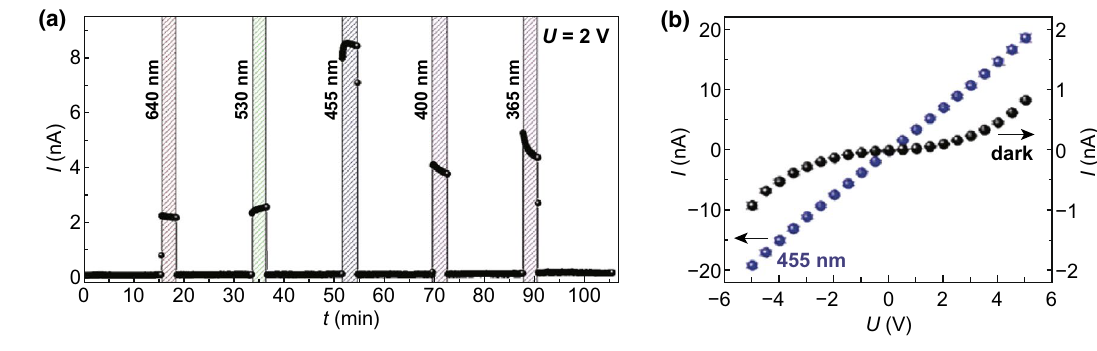
Fig. 2 a DC current I at a voltage of 2 V under irradiations with light of 640, 530, 455, 400, and 365 nm wavelength. b Current–voltage curve of the sample in the dark (black spheres) and under irradiation with 455 nm (blue spheres). Reprinted with permission from Ref. [14]. Copyright 2019, Wiley. (Color figure online)